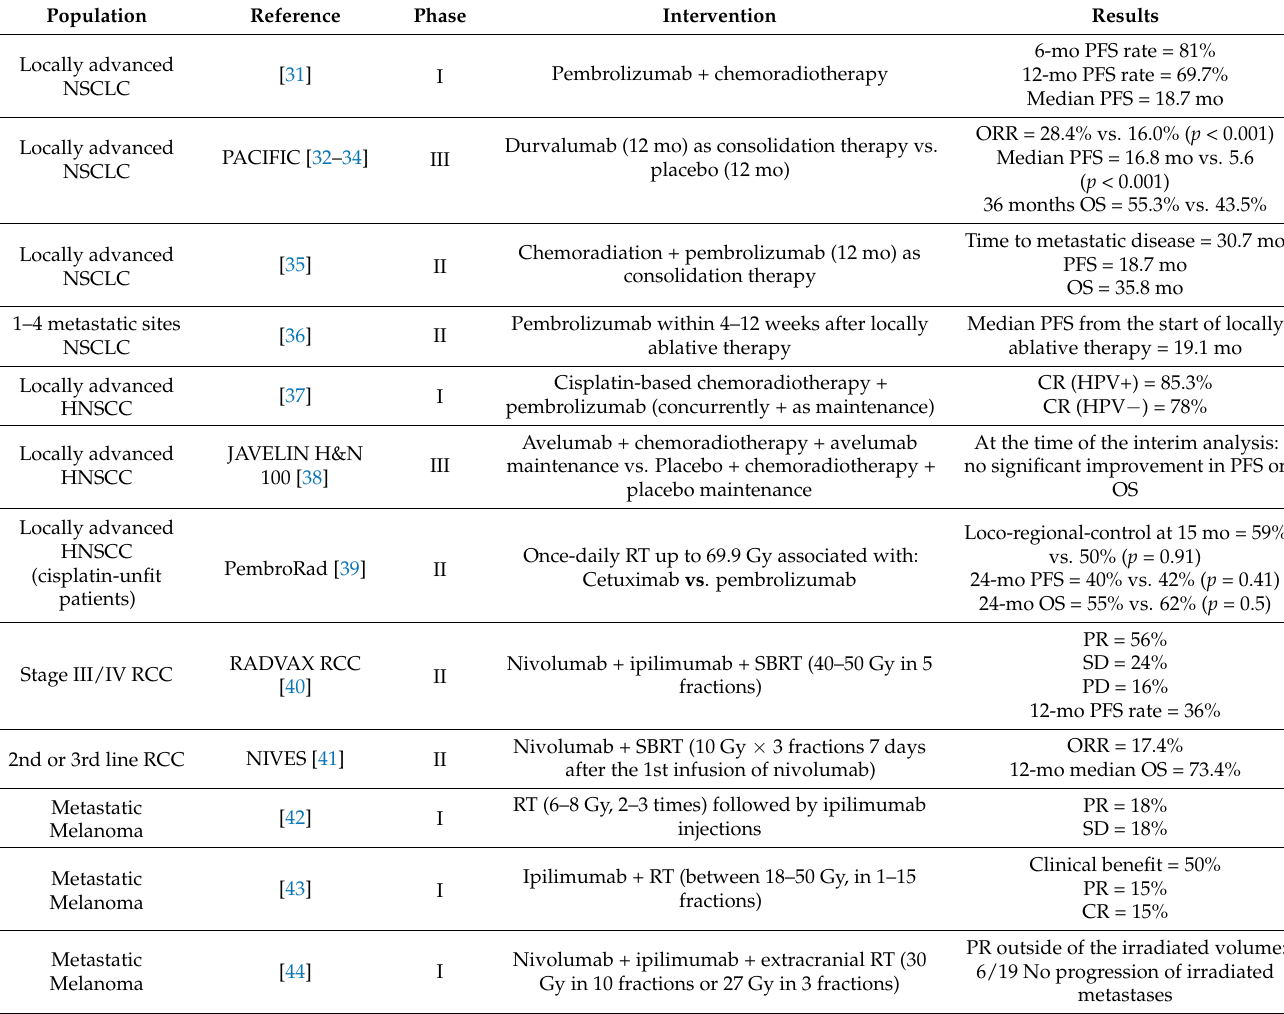
Table 1. Summary of main prospective available data related to the efficacy of radiotherapy and ICI